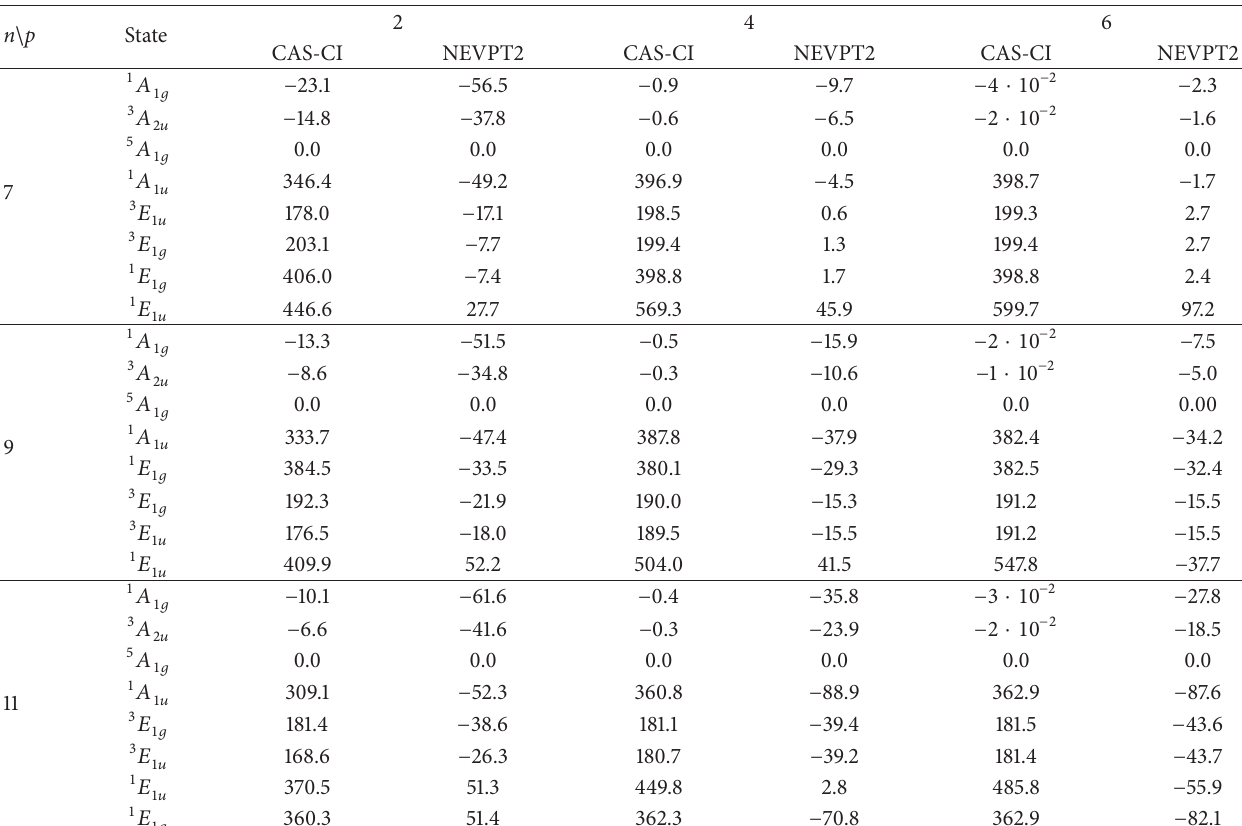
Table 4: CAS-CI and the NEVPT2 energies in kJmol −1 for the class of nanotubes 𝑛 𝑝 , with 𝑛 odd and 𝑝 even. All possible states for a CAS of four electrons in four orbitals have been calculated. n \